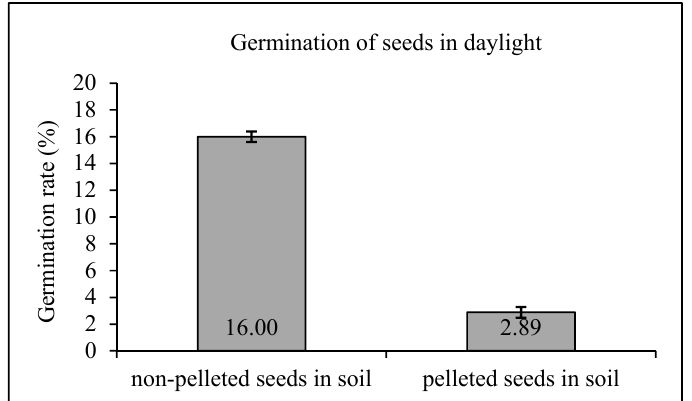
Figure 1. Germination rate in control experiment for pelleted and non-pelleted Scots pine seeds. Vertical bars indicate the standard deviation.